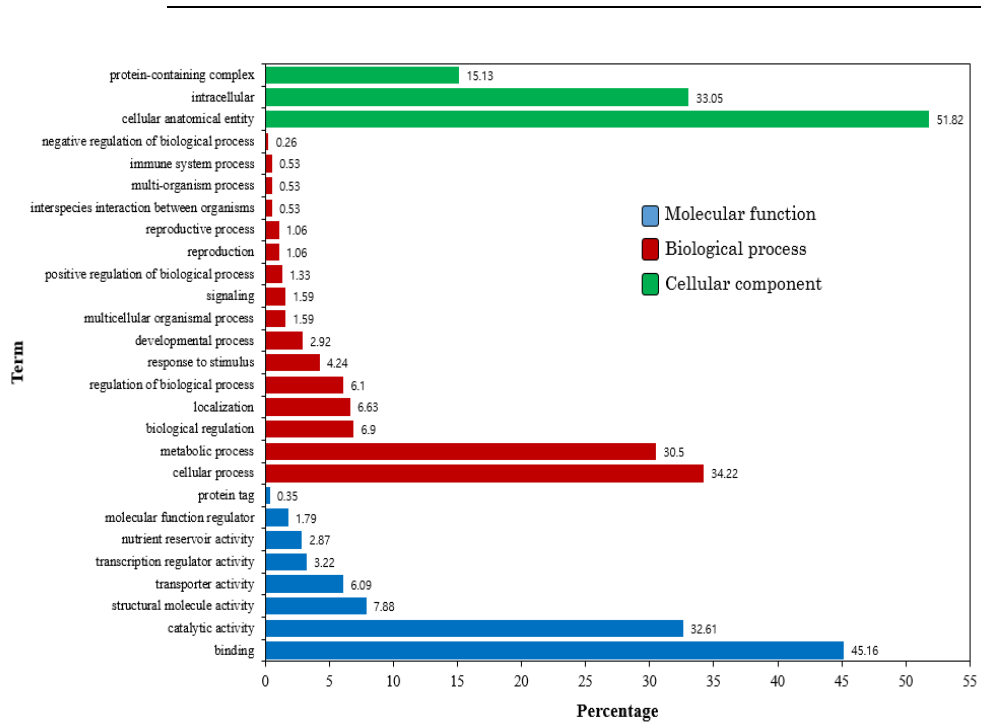
Figure 1. The percentage of genes in different GO sub-categories